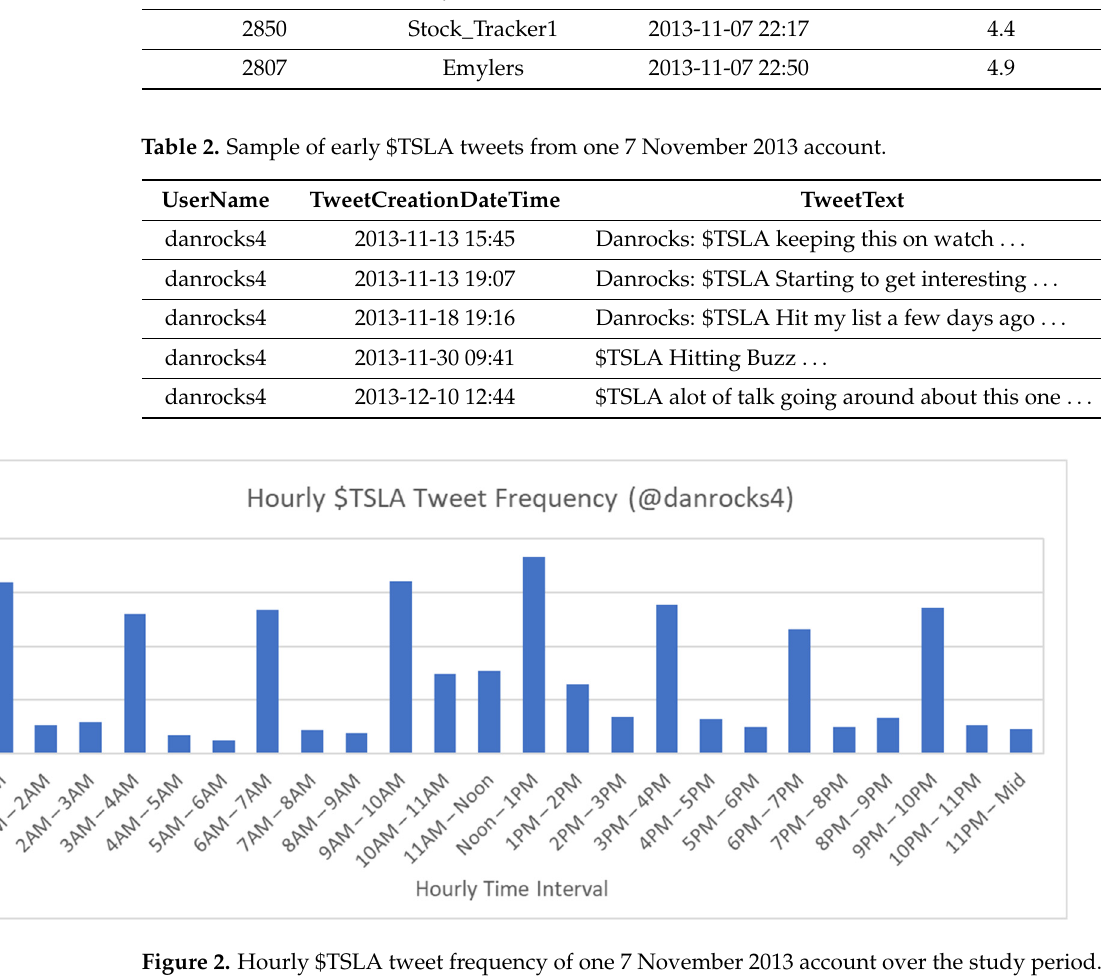
Table 2. Sample of early $TSLA tweets from one 7 November 2013 account.